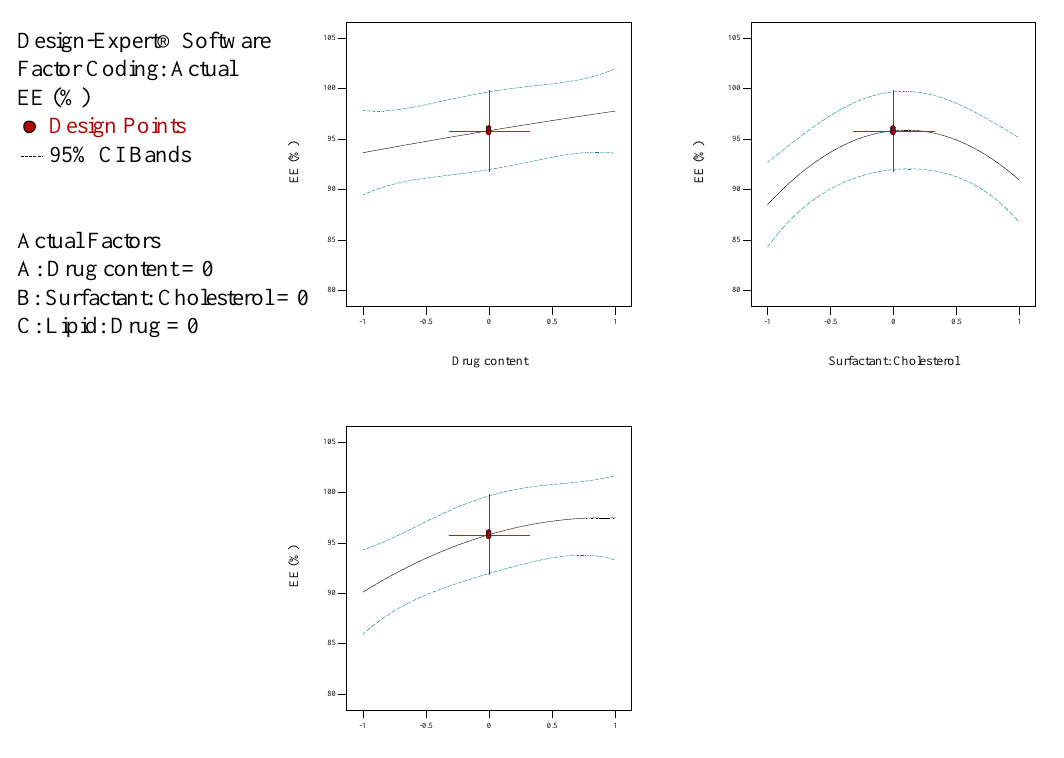
Figure 1. Box–Behnken method for encapsulation efficiency (EE) as a mission of the drug content, molar ratio of surfactant: cholesterol, and molar ratio of lipid: drug.